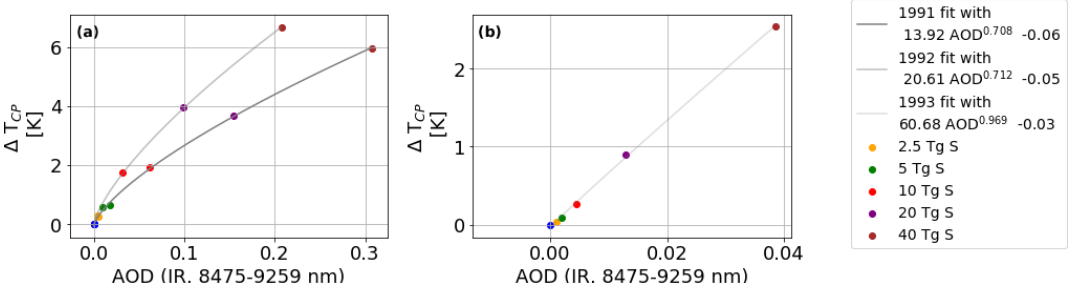
Figure 5. Yearly averages of adjusted tropical cold-point temperature increases as a function of tropical AOD (IR, 8475–9259nm) for the 3 examined years (1991–1993). A power function fit of form a AOD b + c for each year with a corresponding equation is